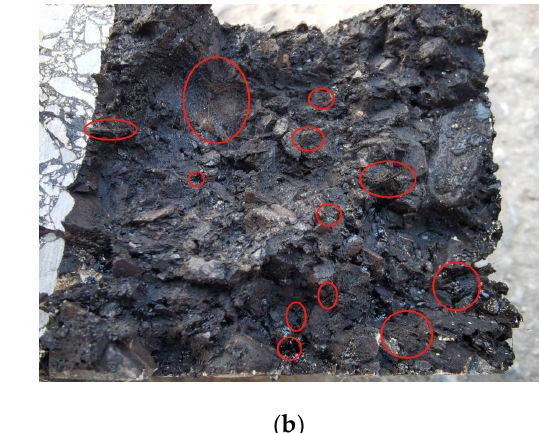
T/S-1 Figure 10. The maximum load and fracture energy of different specimens. As can be seen from Figure 10, the average failure load of BFAC group was 4.86 kN, while that of OAC group was 4.76 kN. There were no obvious differences between the two groups on the failure load, and the addition of basalt fibers did not show the great improvement effect on the bending failure load as expected. In terms of fracture energy, the average fracture energy of the BFAC group was 11.24 kN·mm, while that of the OAC group was 9.02 kN·mm. The average fracture energy of the BFAC group was significantly higher than that of the OAC group and the average fracture energy increased by 24.6%, indicating that the load curve of BFAC dropped more slowly and covered a larger area compared with OAC; the asphalt concrete with basalt fibers added has better crack re- sistance effect after failure load, which is the propagation process of macrocrack. 4.2. Analysis Based on AE Parameters For AE parameters, the specific values varied with different specimens while the var- iation trends and rules were similar and consistent. In this paper, S1 of OAC and T2 of BFAC specimens are taken as representative examples for discussion and analysis. As shown in Figure 11, basic AE parameters of OAC and BFAC during the test are collected and analyzed, including duration, ringing counts, and cumulative ringing